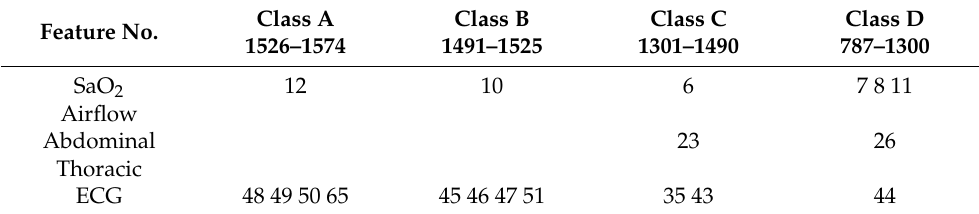
Table 3. Feature classes via the distribution of λ feature in the experiment with event duration. Feature No.